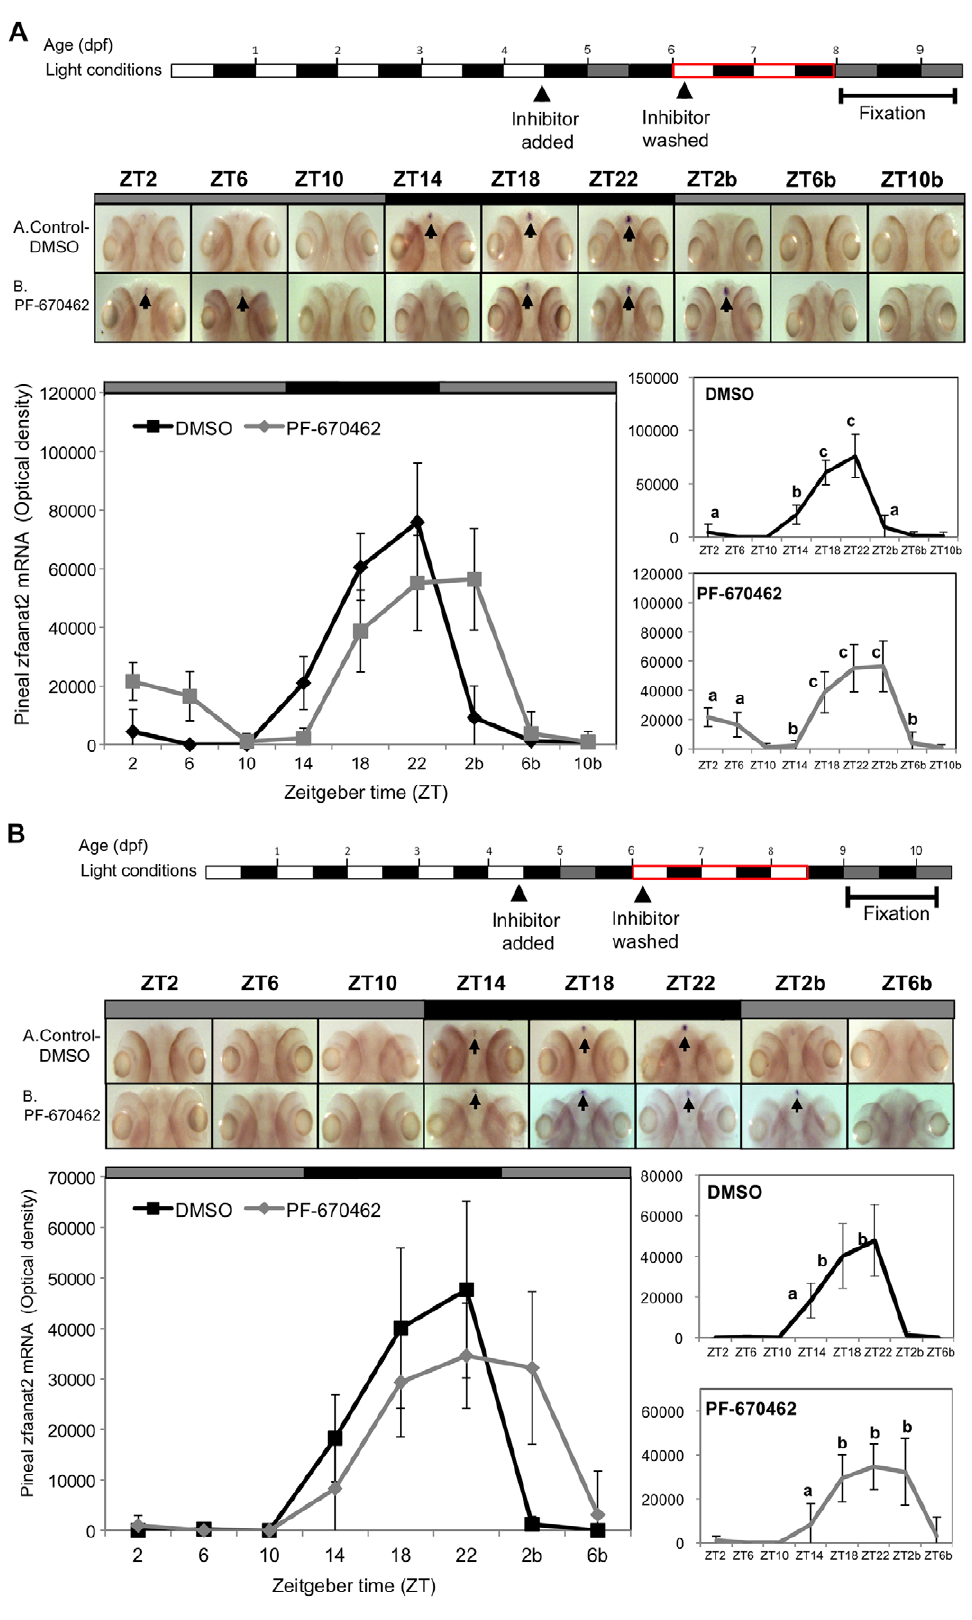
Figure 6. The effect of CK1 d inhibition on rhythmic pineal aanat2 mRNA expression is reversible. Reversibility was determined after two (A) or three (B) LD cycles for re-entrainment. Top panels : Experimental design. The horizontal bars represent the light conditions before and during sampling; white boxes represent light, grey boxes represent subjective day and black boxes represent dark. Middle panels: Whole-mount ISH signals